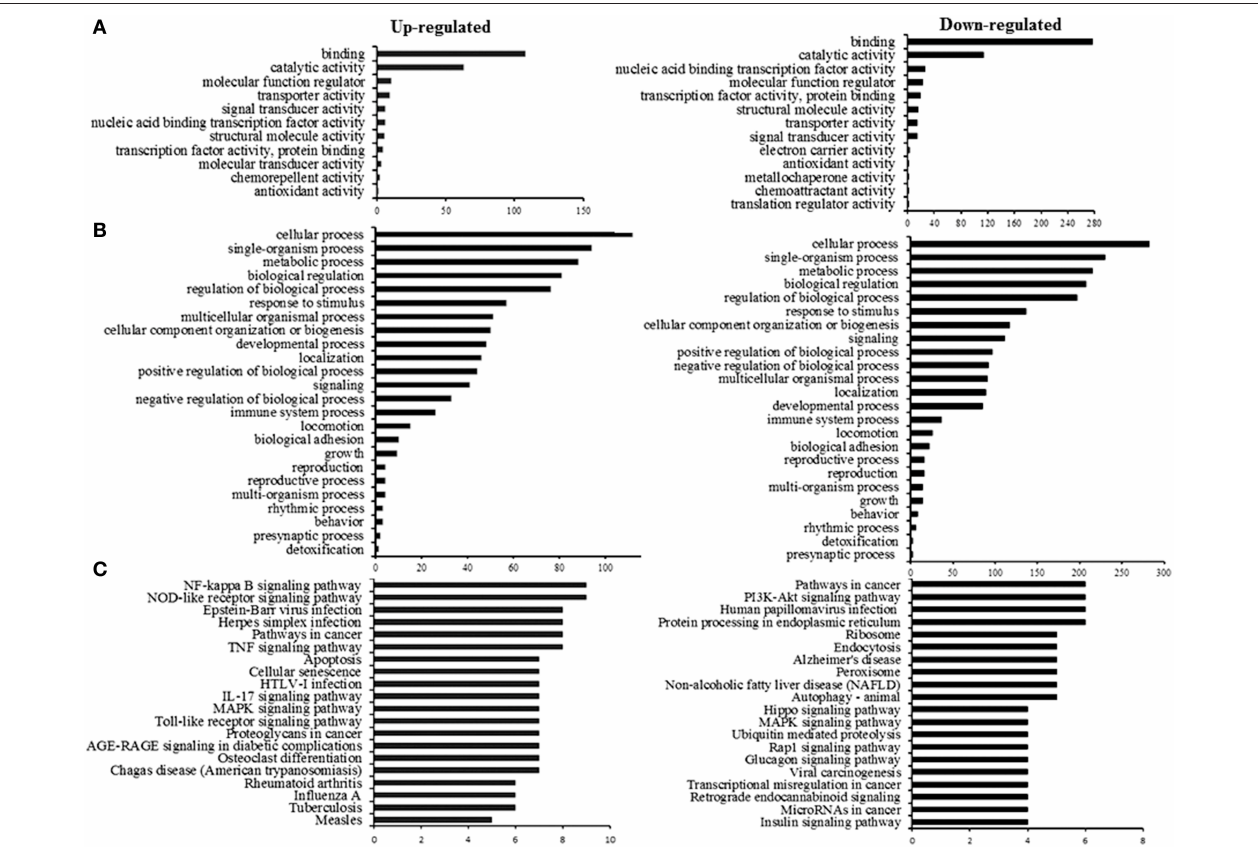
FIGURE 3 | Functional characterization of the up-regulated and down-regulated proteins. (A) Molecular function (GO-MF) analysis. (B) Biological process (GO-BP) analysis. (C) KEGG Pathway